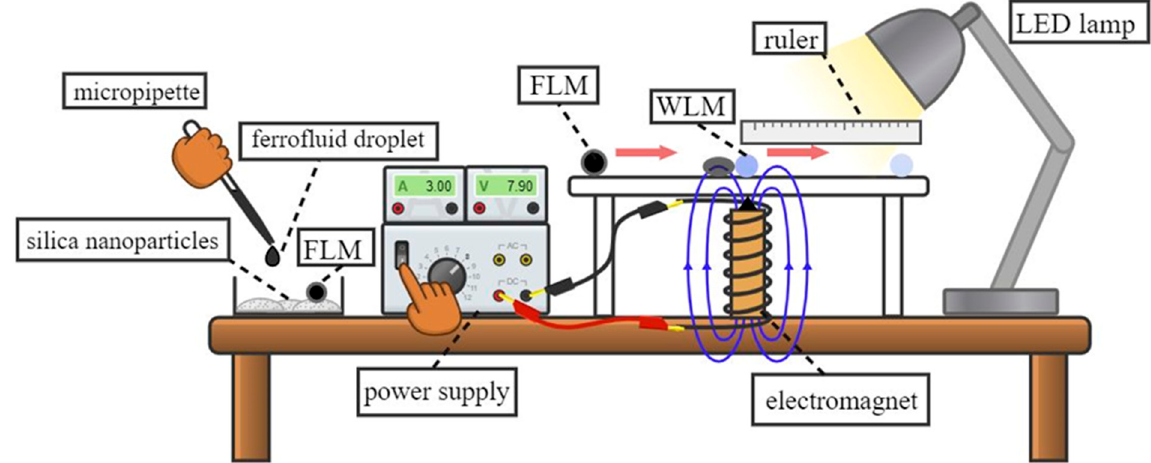
Figure 1. Schematic of the apparatus .